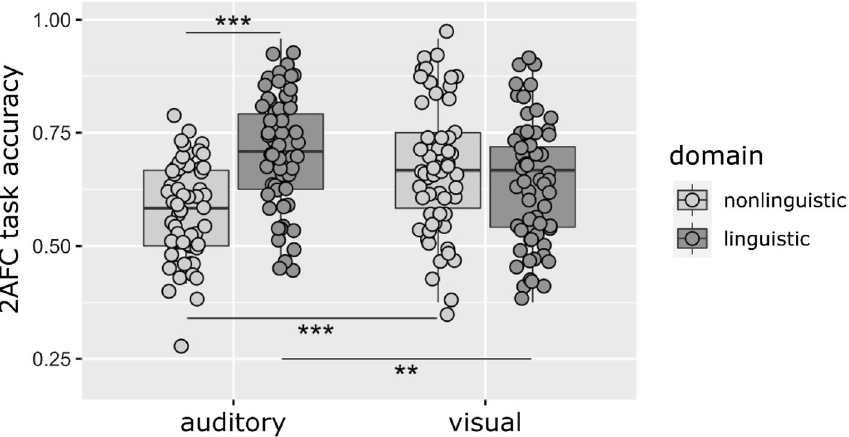
Figure 7. 2AFC accuracy by Modality and Domain with the optimal Presentation for each modality ( serial presentation for auditory stimuli, and simultaneous presentation for visual stimuli). Dots represent the mean accuracies of individual participants in a given group (a small amount of jitter was added to increase visibility). Lines in boxes represent group medians, box lengths illustrate the group interquartile range, and whiskers show minimum and maximum values. Outliers are participant data which are outside the 1.5 interquartile range beyond the first and third quartiles. *: p < 0.05, **: p < 0.01, ***: p < 0.001. Performance in the auditory linguistic condition was higher than performance in the auditory nonlinguistic condition and performance in the visual linguistic condition; and performance in the visual nonlinguistic condition was superior to performance in the auditory nonlinguistic condition (regardless of Training